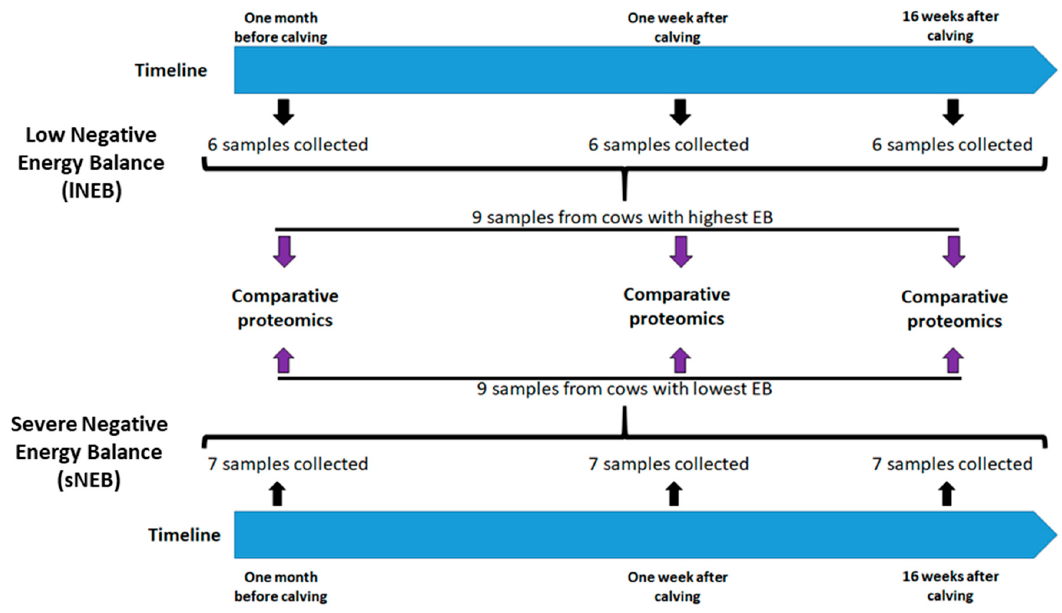
Figure 1. Experimental design and timeline of sample collection. The adipose tissues of two experimental groups (lNEB and sNEB) were analyzed in three different time points. Among the samples of each group, three were collected and analyzed for differential protein